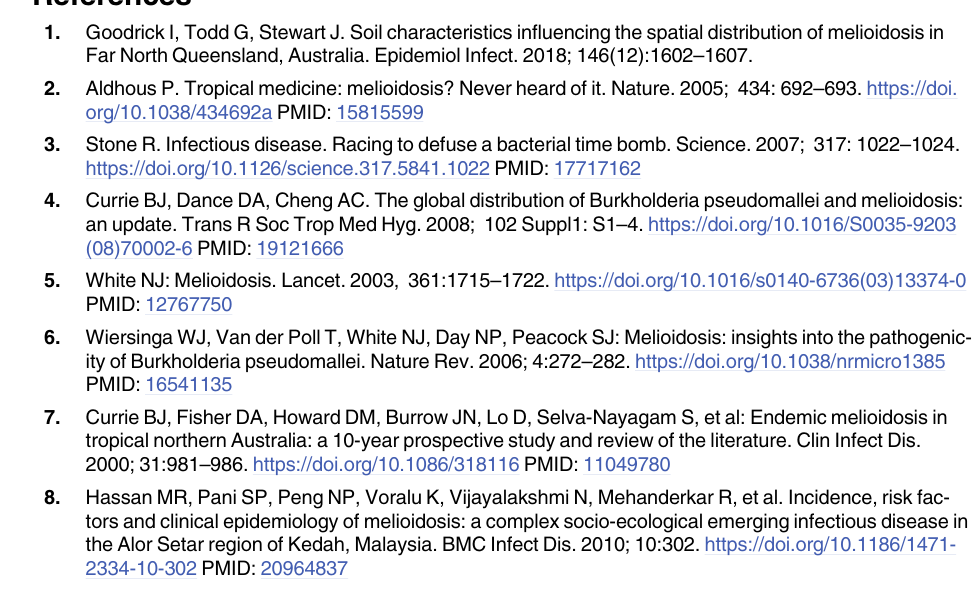
S1 Fig. Flow diagram showing selection of melioidosis cases, in the case control study, Udupi District,